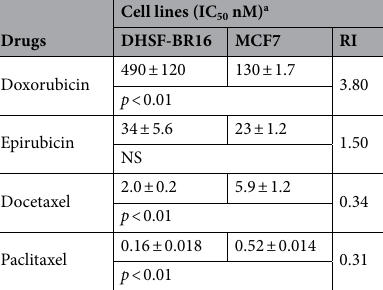
Table 2. IC 50 values of anticancer drugs tested on DHSF-BR16 cell line compared to the breast cancer cell line MCF-7. a The IC 50 values are the mean ± ES of at least three experiments conducted in quadruplicate. p calculated as t test; NS, Not